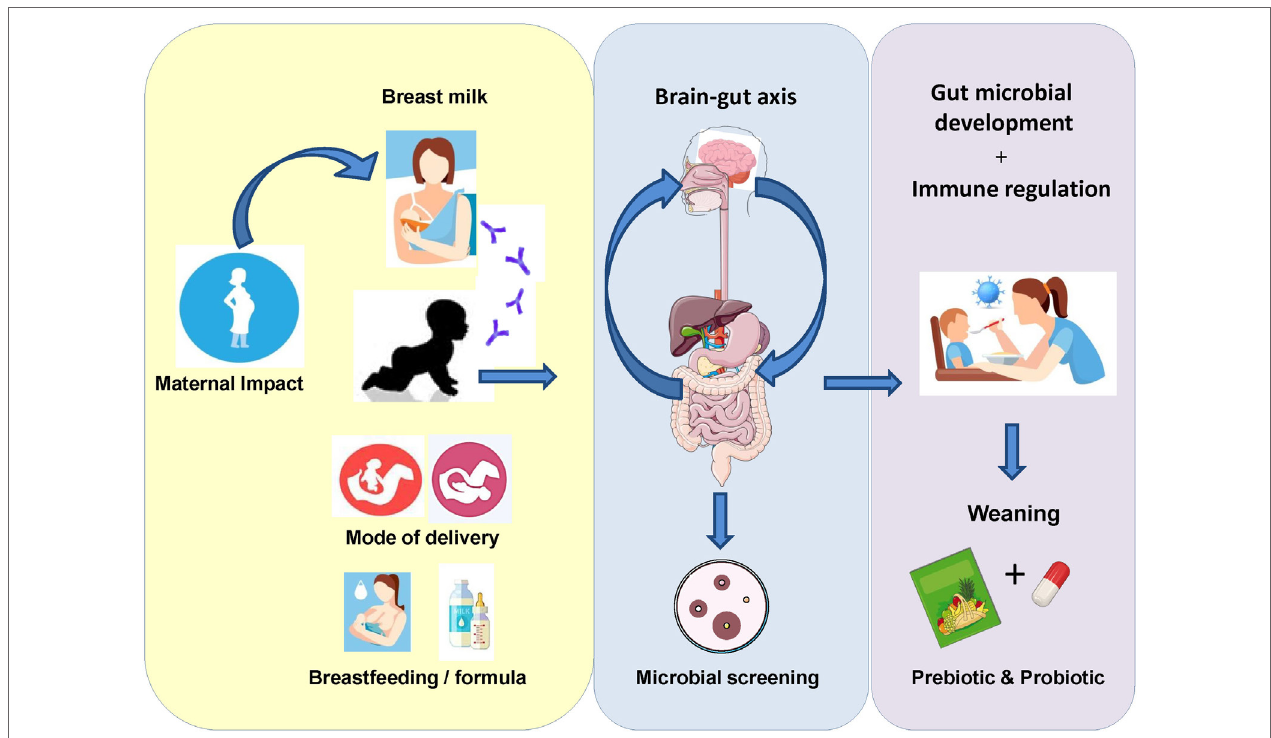
FigURe 1 | Initial exposure to the microbial environment surrounding the infant can have a significant impact on gut microbiota development. External factors, such as maternal health status, mode of delivery, gestational age, and feeding regime, can impact the colonization and flux of microorganisms during this critical period in life. Subsequently, multiple studies have begun to focus on how these factors can affect the gut microbiome in early life. Moreover, in order to improve the health status of the infant gut, current focus is on the effect of probiotics and prebiotics in terms of their potential multifaceted health benefits. The current mini-review outlines a number of studies where either pro- or pre-biotics were utilized as a microbial therapeutic to improve infant